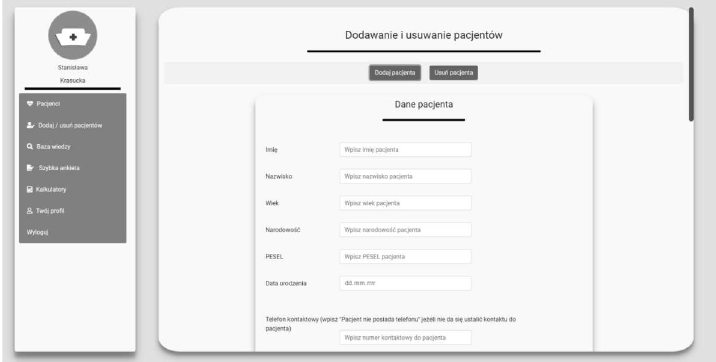
Figure 5. Appearance of the module allowing to add a new patient – part 1